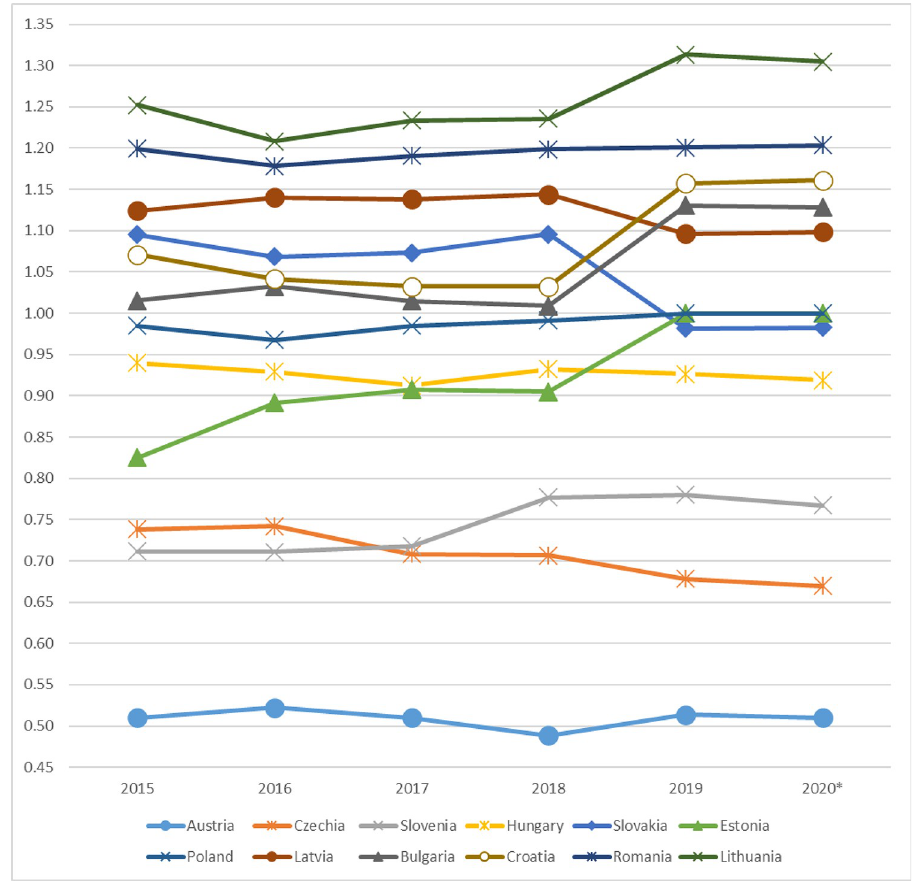
Fig 6. 3SI synthetic anchor ratio projection for the second half of 2020 (3-element weighted